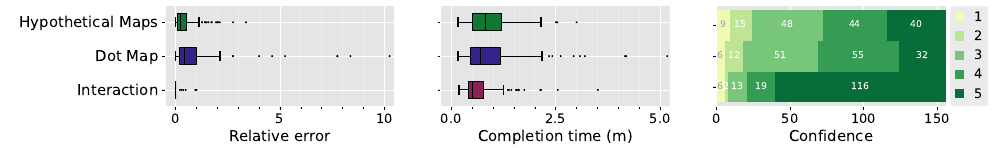
Figure 4. Results of the retrieve value